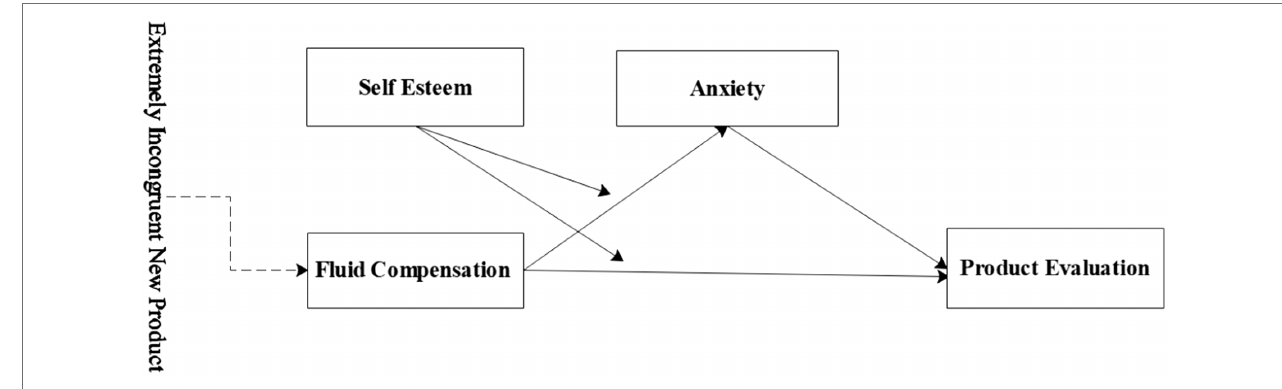
FIGURE 1 | Research